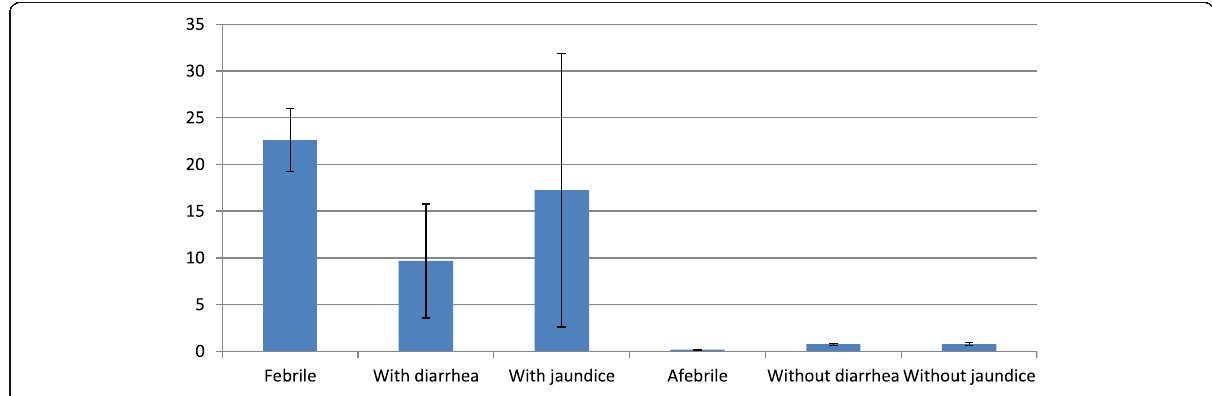
Fig. 3 Malaria prevalence in pregnant women at state level — with and without symptoms (% malaria positive with 95%